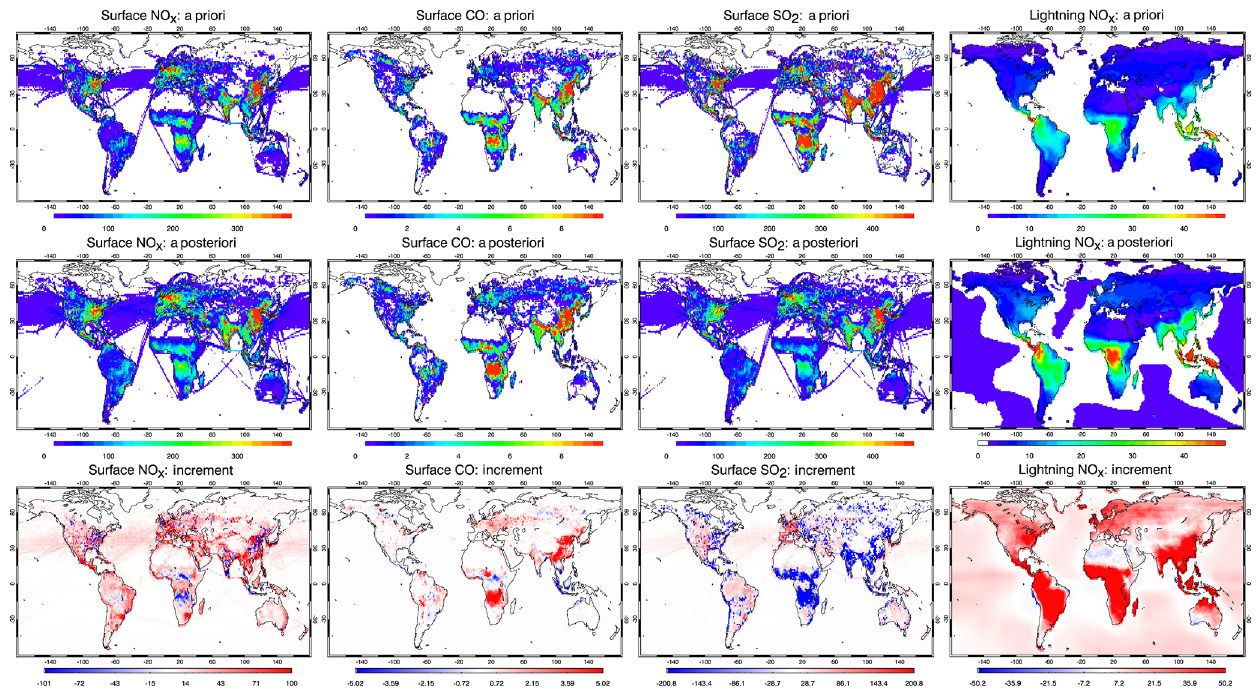
Figure 12. Global distributions of surface NO x emissions (in 10 − 13 kgNm − 2 s − 1 ) (left column), surface CO emissions (in 10 − 10 kgCOm − 2 s − 1 ) (second column), surface SO 2 emissions (in 10 − 13 kgSm − 2 s − 1 ) (third column), and lighting NO x sources (in 10 − 14 kgNm − 2 s − 1 ) (right column) averaged over 2005–2018. The a priori emissions (upper row), a posteriori emissions (middle row), and analysis increment (lower row), i.e., the difference between the a posteriori and the a priori emissions, are shown for each panel.